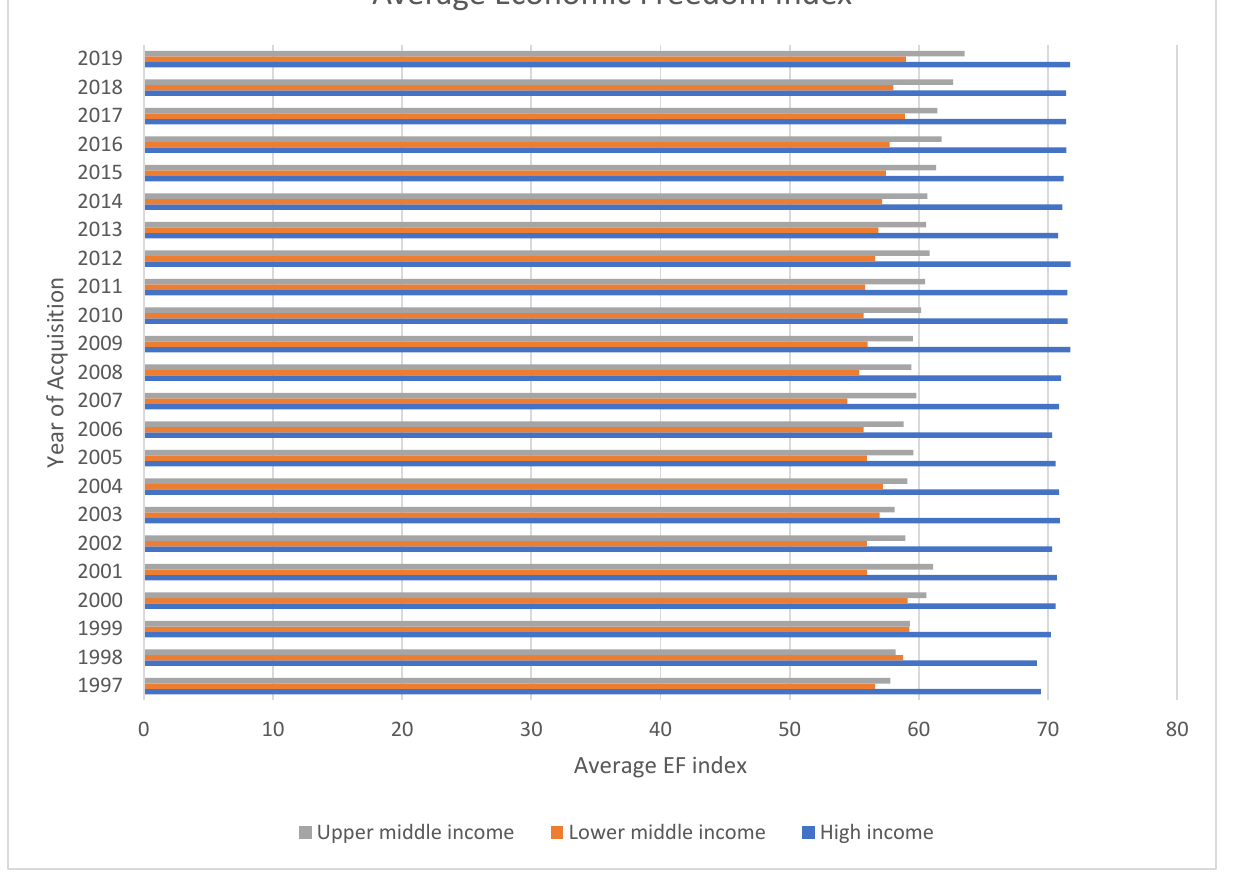
Figure 2. Average Economic Freedom Index of countries during the study period. (Source: Authors’ presentation based on the Economic Freedom Index data collected from the Fraser Institute— www.fraserinstitute.org/studies/economic-freedom-of-the-world-2020-annual-report, accessed on 5 May 2022).